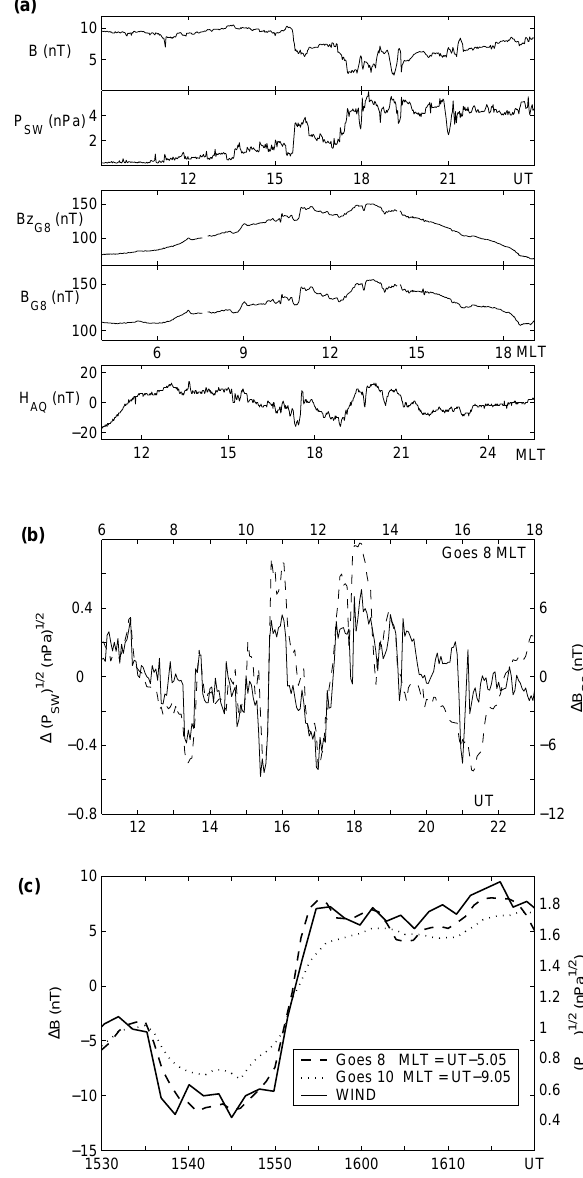
Fig. 1. ( a ) A comparison between Wind, Goes 8 and ground obser- vations at L’Aquila for 12 May 1999 (09:00–24:00 UT). From the top: B is the IMF intensity, P SW the SW dynamic pressure, B zG 8 the north-south component of the magnetospheric field in GSM co- ordinates, B G 8 the total magnetospheric field, and H AQ the north- south component of the geomagnetic field. Magnetospheric and ground observations are organized in Magnetic Local Time (MLT). ( b ) The correspondence between the 3-min averages of the square root of the SW pressure (solid line) and the magnetospheric field (dashed line) (11:00–23:00 UT). SW observations have been de- layed by 12 minutes. In both cases the long-term variations have been removed. On the top scale the MLT at Goes 8. ( c ) A com- parison between the square root of the SW pressure (solid line) and the magnetospheric field from Goes 8 (dashed line), and Goes 10 (dotted